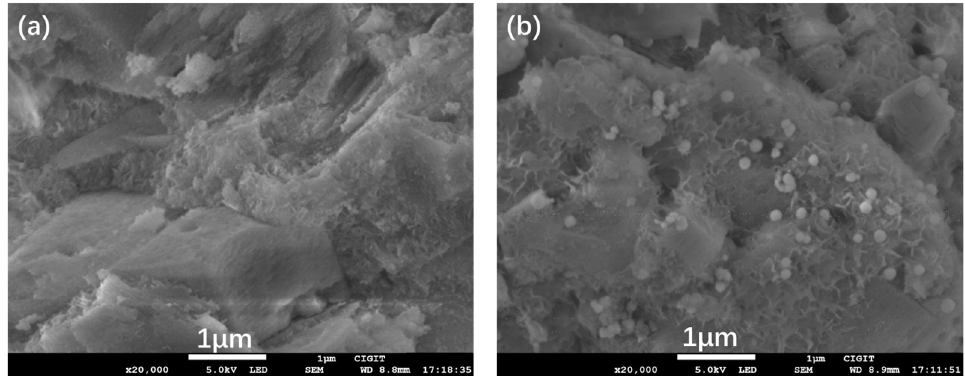
Figure 1. SEM images of the Al 2 O 3 and ZVI-ALOX particles: ( a ) Al 2 O 3 microspheres; ( b ) ZVI-ALOX microspheres.